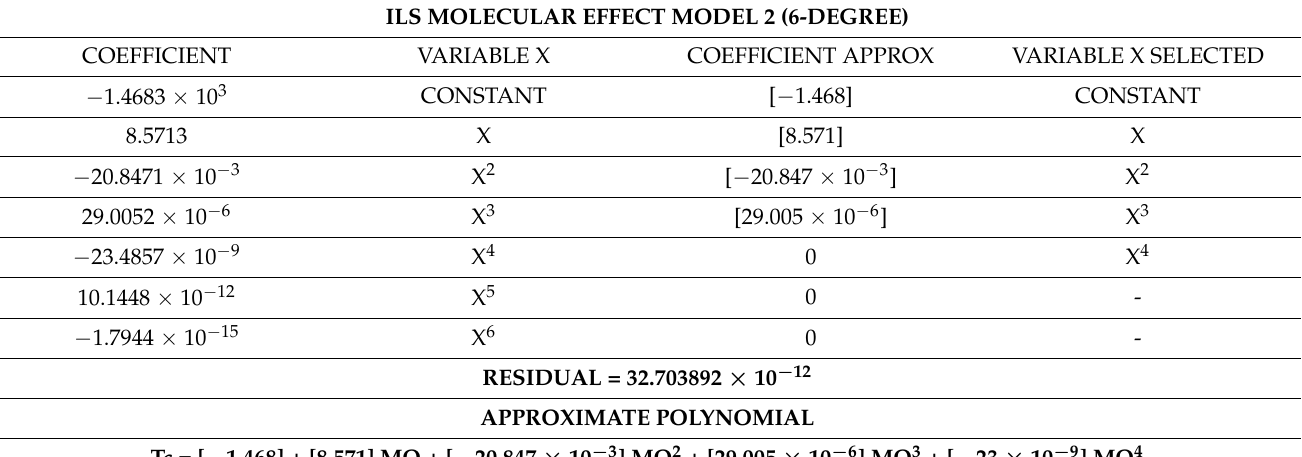
Table 5. Numerical results for the molecular effect model using the 6-degree polynomial method and the approximated equation. For the approximation, a quadratic polynomial is set.